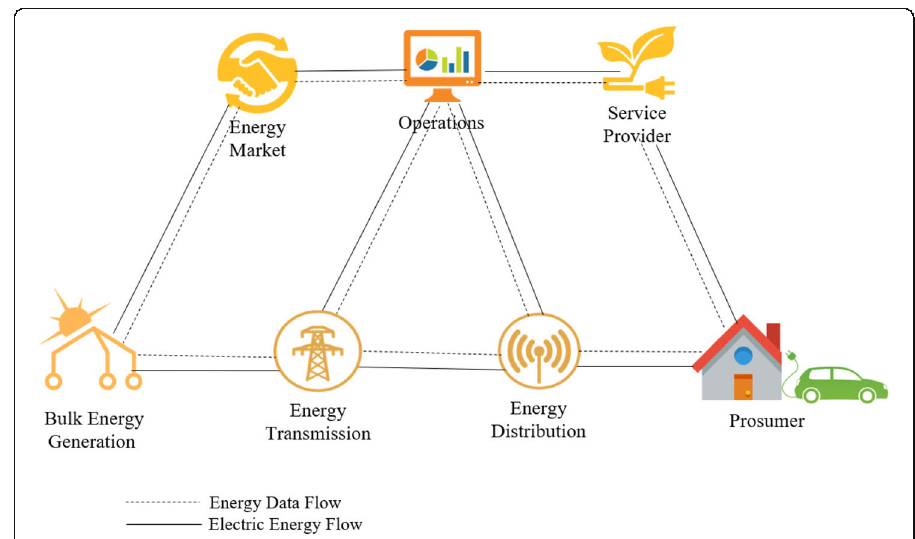
Fig. 3 Smart grid, prosumers and energy